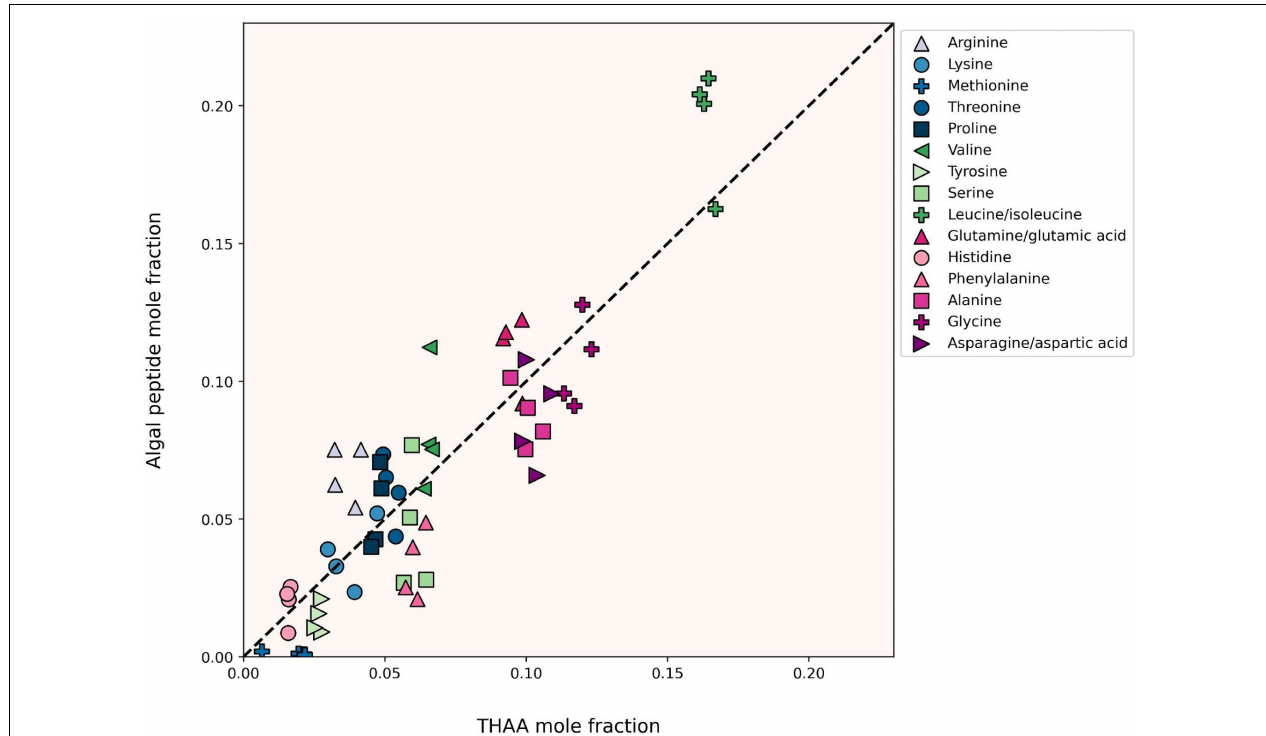
FIGURE 5 | Mole fractions of individual amino acids from all four degradation time points as derived from total acid hydrolyzable amino acid analysis (THAA, x -axis) and tandem MS/MS-based proteomics (Peptide, y -axis). The dashed 1:1 line represents perfect agreement between approaches. The peptide amino acid compositions plotted here are derived from both trypsin-digested and naturally digested proteomics fractions. Label-free peptide quantitation was determined by the relative peptide area